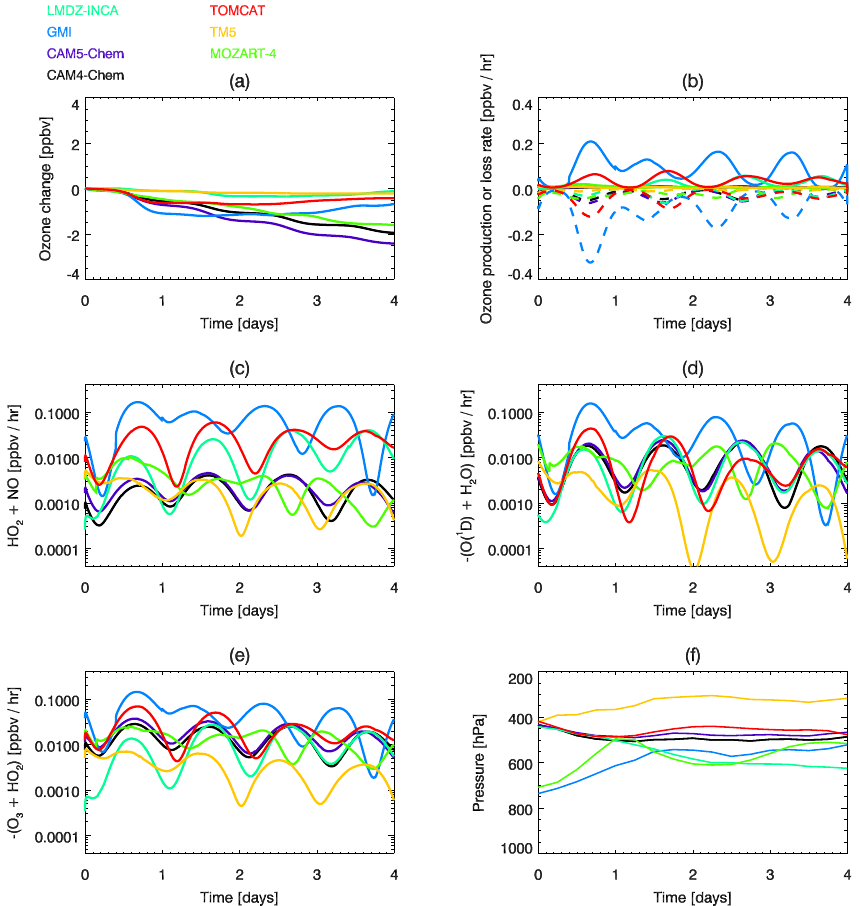
Figure 12. CiTTyCAT Lagrangian box model simulations of fire plume ozone evolution in the Arctic. Coloured lines show simulations initialized with chemical composition from each of the POLMIP global models at the fire plume maxima locations at 06:00UT on 7 July 2008. (a) Net ozone change over the 4-day simulations. (b) Integrated ozone production (solid) and loss (dashed) rates. (c) Rate of HO 2 + NO ozone production; (d) Rate of O ( 1 D ) + H 2 O ozone loss; (e) Rate of HO 2 + O 3 ozone loss; (f) Pressure of forward trajectories from each POLMIP model plume maximum position used for the Lagrangian simulations. See text for details of the Lagrangian model simulations.